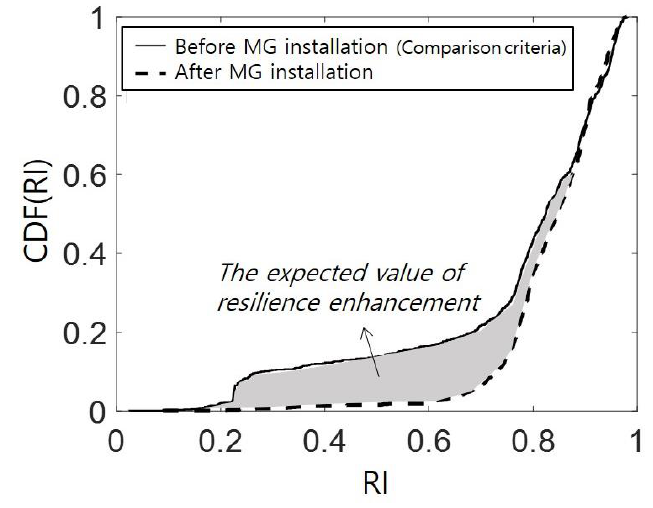
Figure 6. Example of EoRE.